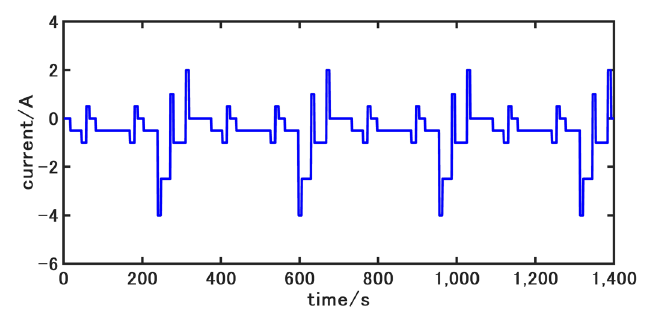
Figure 6. Current of DST Driving Condition.